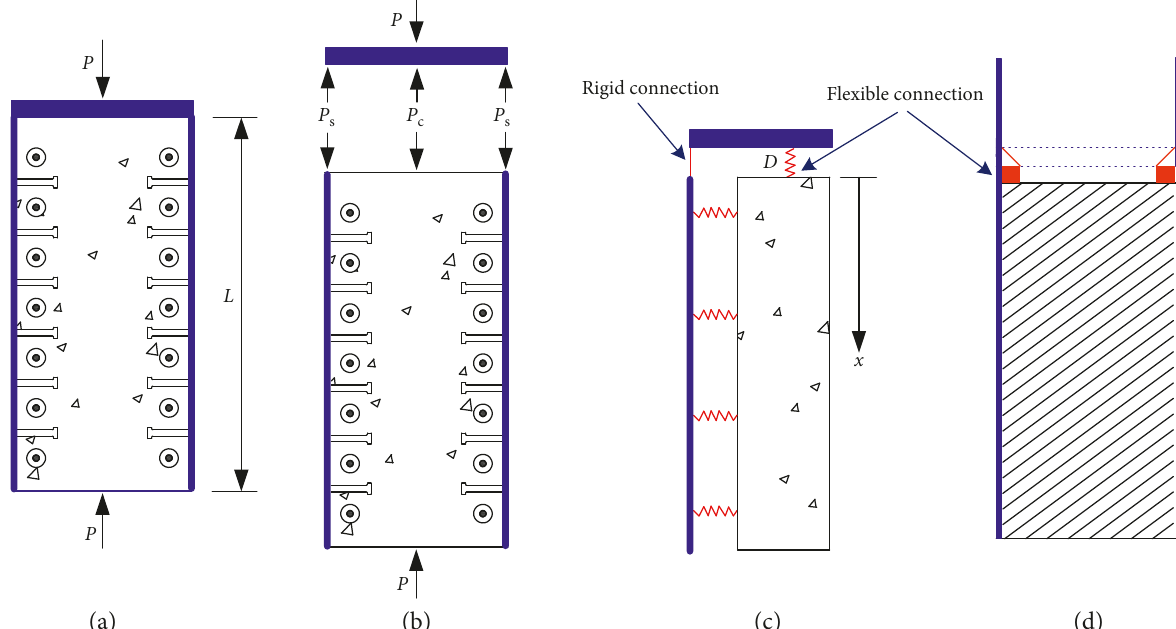
Figure 5: Theoretical analysis model for the joint. (a) Simplified model. (b) Force boundary condition. (c) Displacement condition. (d) Local compressive